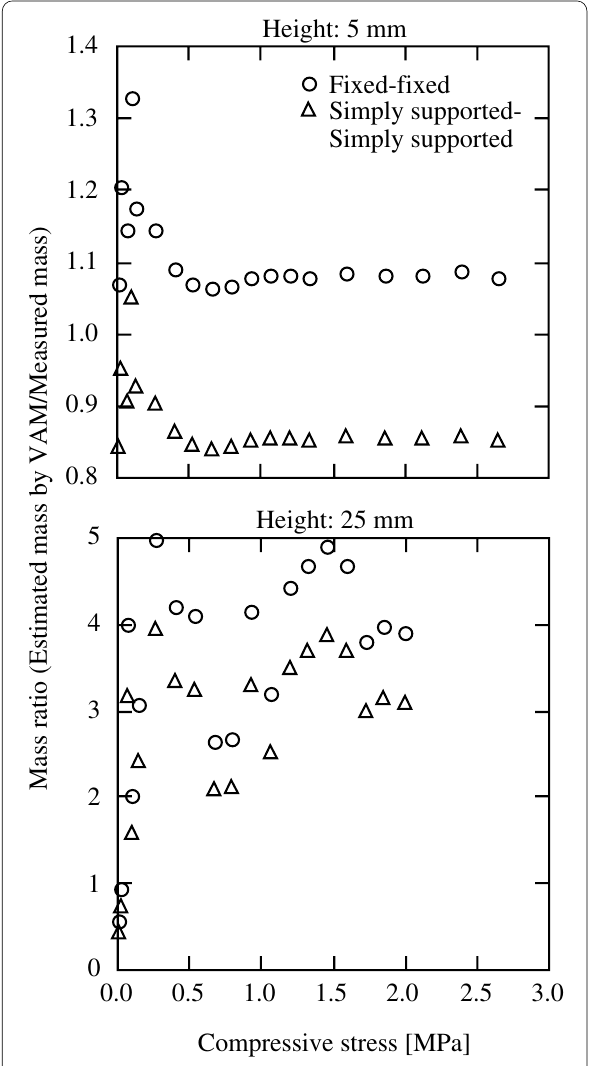
Fig. 4 Example of the changes in the estimation accuracy of VAM during the increase in compressive